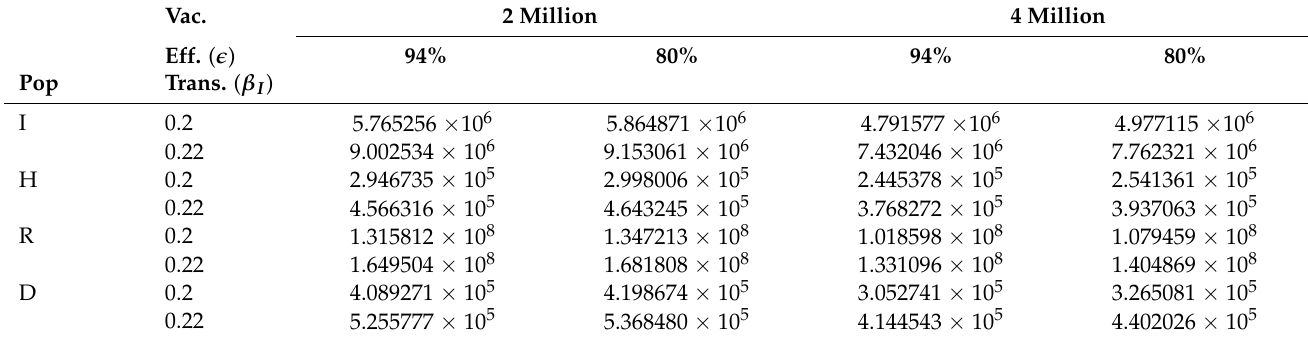
Table 3. Impact of the inoculation rate (Vac.) and the efficacy ( (cid:101) ) of the vaccine on the peak of the infected (I) and hospitalized (H) subpopulations. In addition, on the deaths (D) and recovered (R) cases. In these scenarios, the infectiousness of the asymptomatic individuals relative to symptomatic is 100% ( β A = β I ), and the percentage of infections that are asymptomatic is 50%.